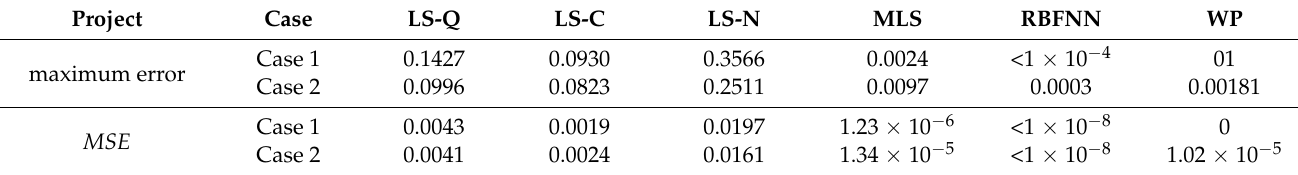
Table 3. Maximum error and MSE for TD3.